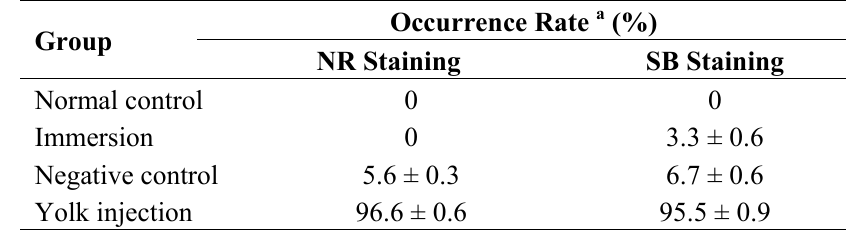
Table 2. Yolk leukocyte recruitment